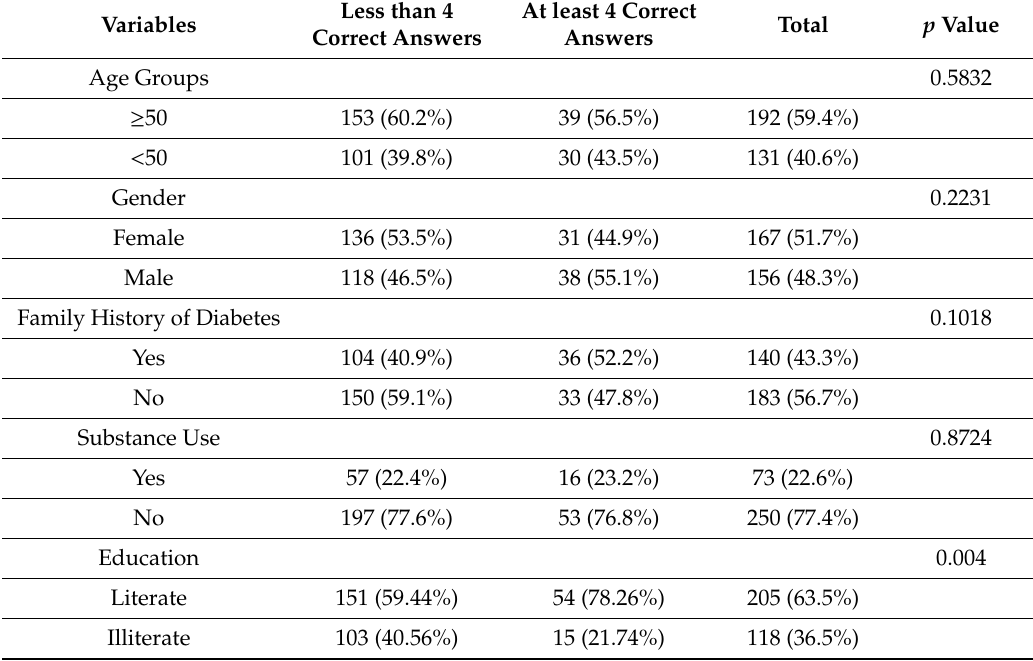
Table 2. Knowledge scores among the patients stratified on the basis of demographic and clinical